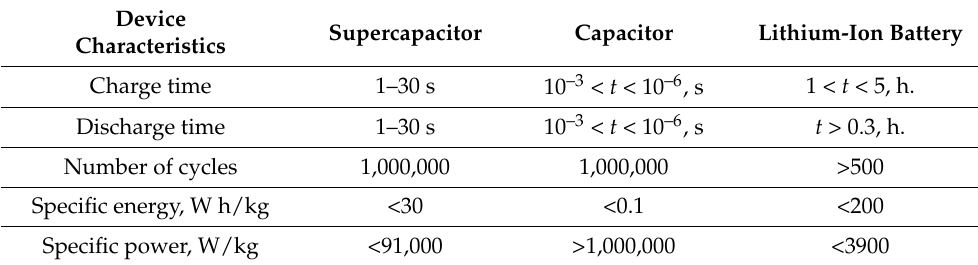
Table 1. Characteristics of supercapacitor, capacitor and lithium-ion